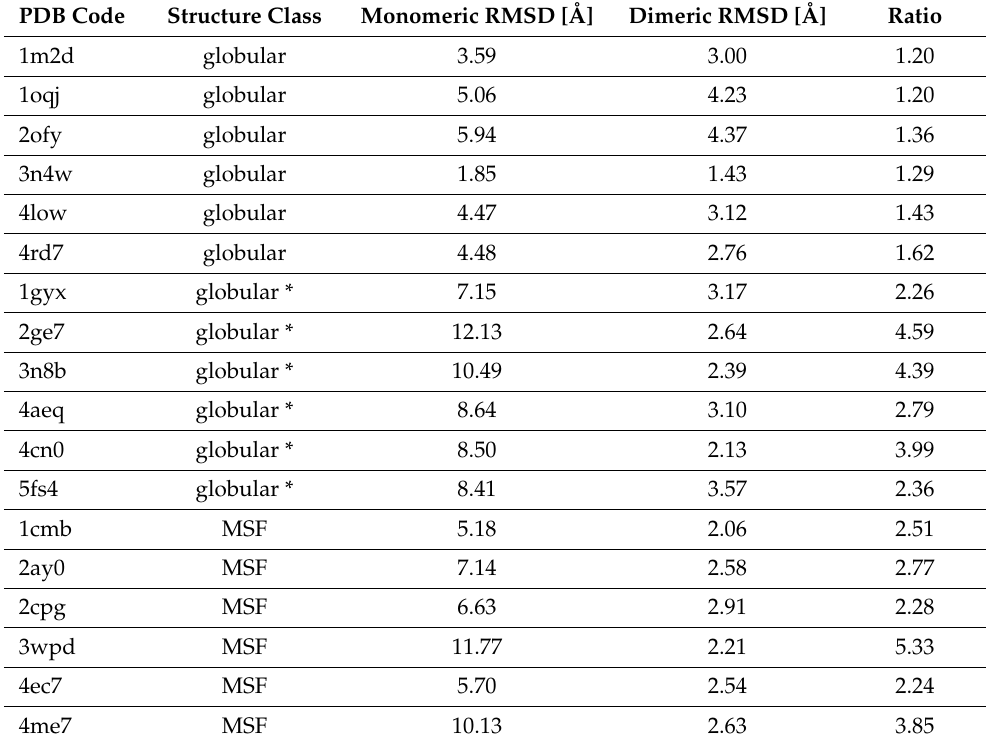
Table 1. Average RMSD values obtained from the monomeric and dimeric MD simulations. PDB